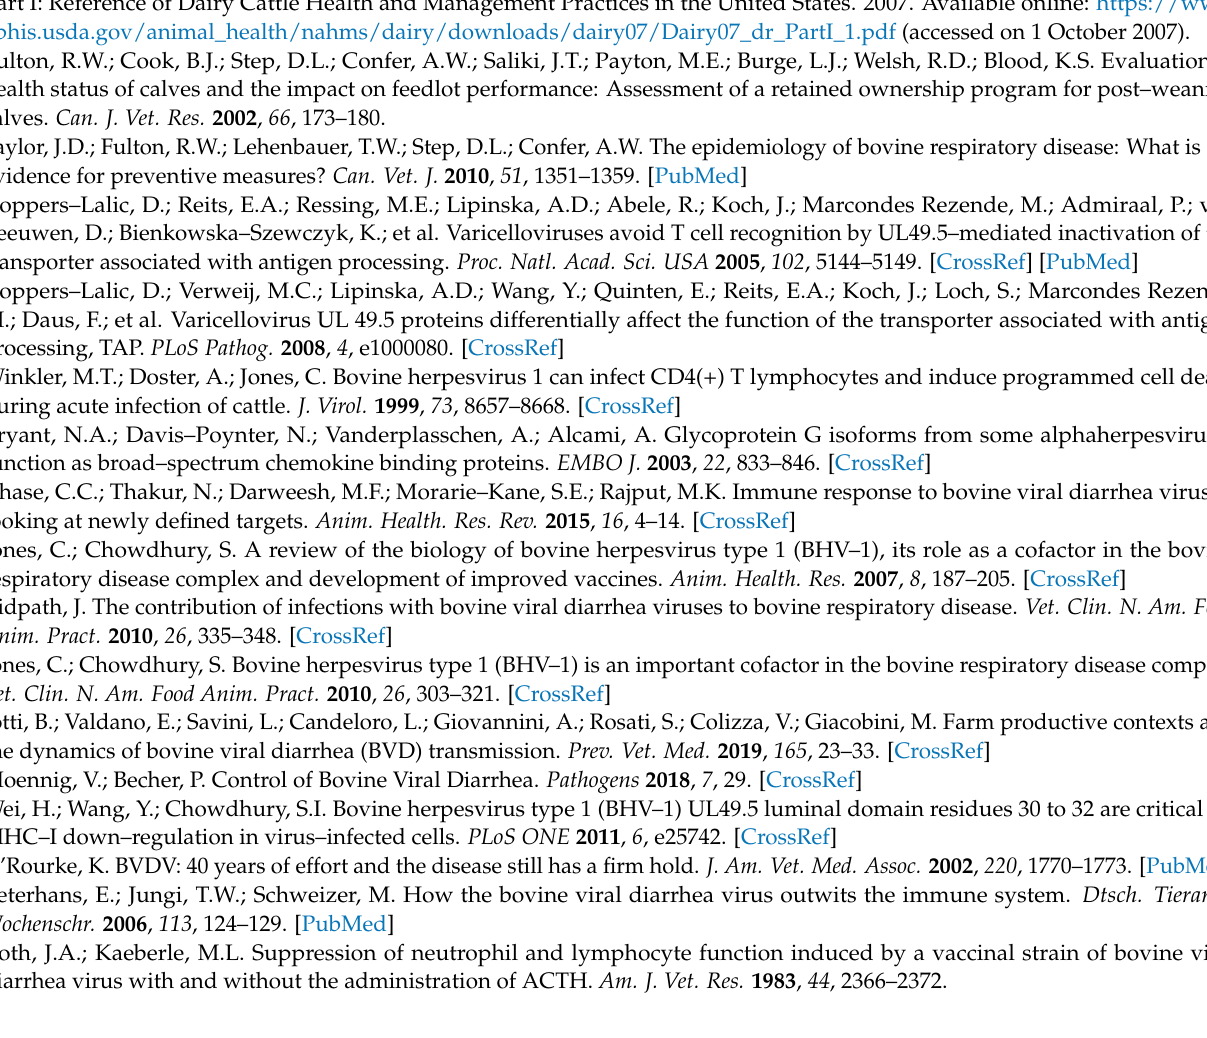
INS); Table S1: Clinical scoring scheme; Table S2: BVDV–2–specific serum neutralizing antibody response; Table S3: Leukocyte counts in animals for each treatment group at indicated days post– vaccination and post–challenge; Table S4: BVDV–2 nasal virus shedding following challenge; Table